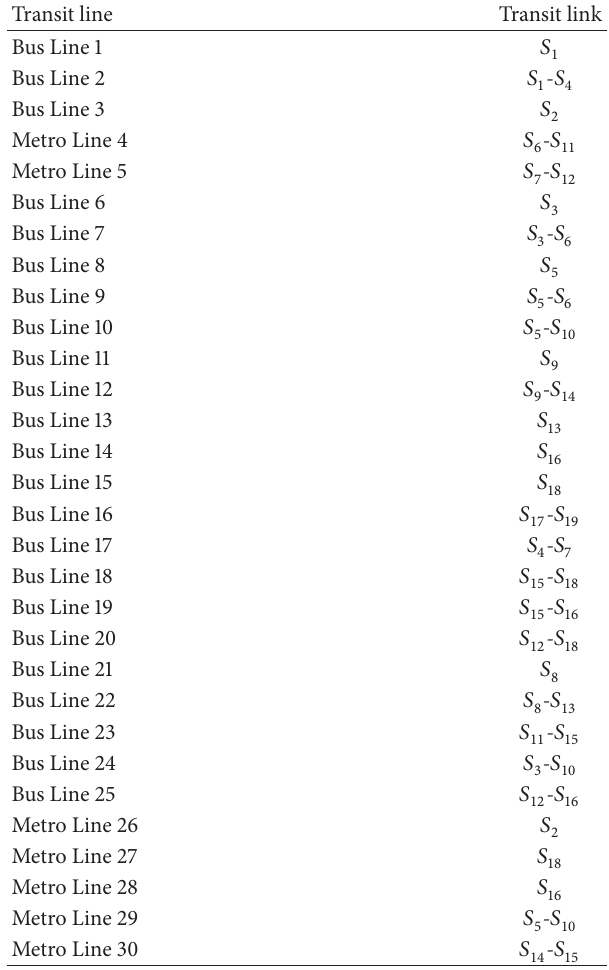
Table 2: OD pairs and transit routes of the example transit network. OD pair 𝑔 0 𝑤